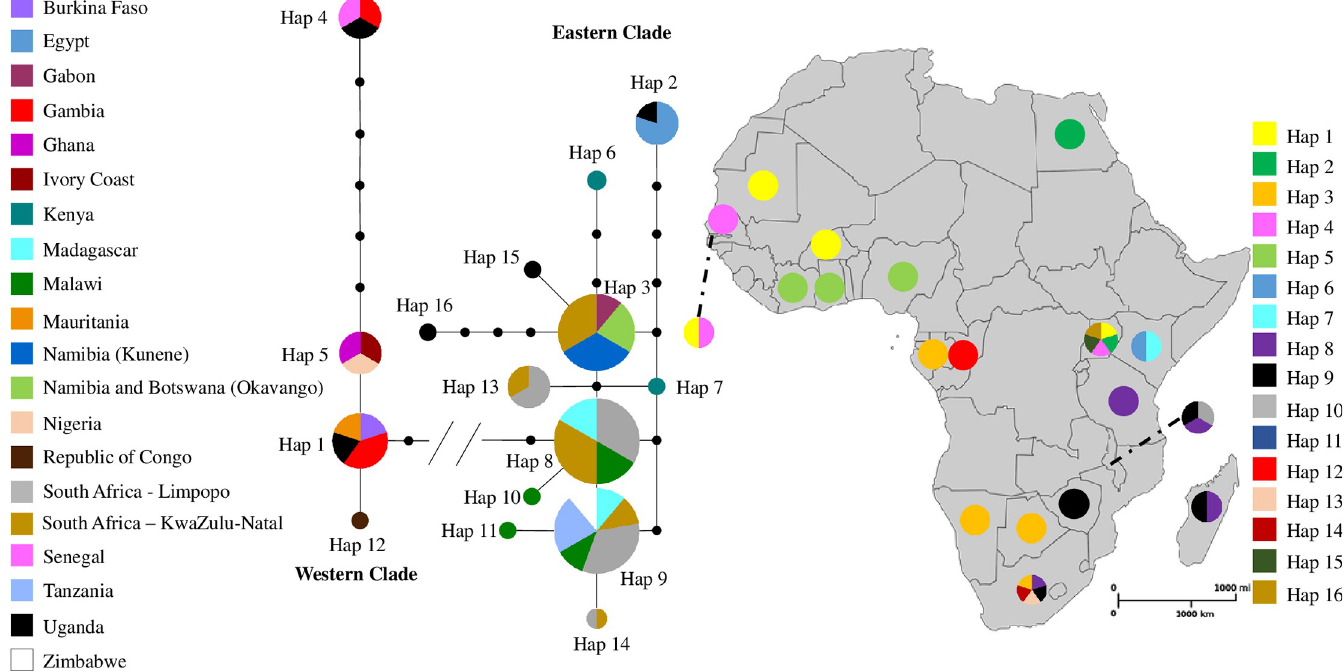
Fig 1. Median-joining network of Nile crocodile ( C . niloticus and C . suchus ) and geographic distribution of haplotypes. Based on a 516 bp fragment of the mtDNA control region, 16 haplotypes in continental Africa and Madagascar using new and previously published sequences were observed. The size of the circles is proportional to the frequency of the haplotype; lines represent a single substitution step; black dots represent hypothetical unobserved haplotypes; // represents 16 mutational steps.